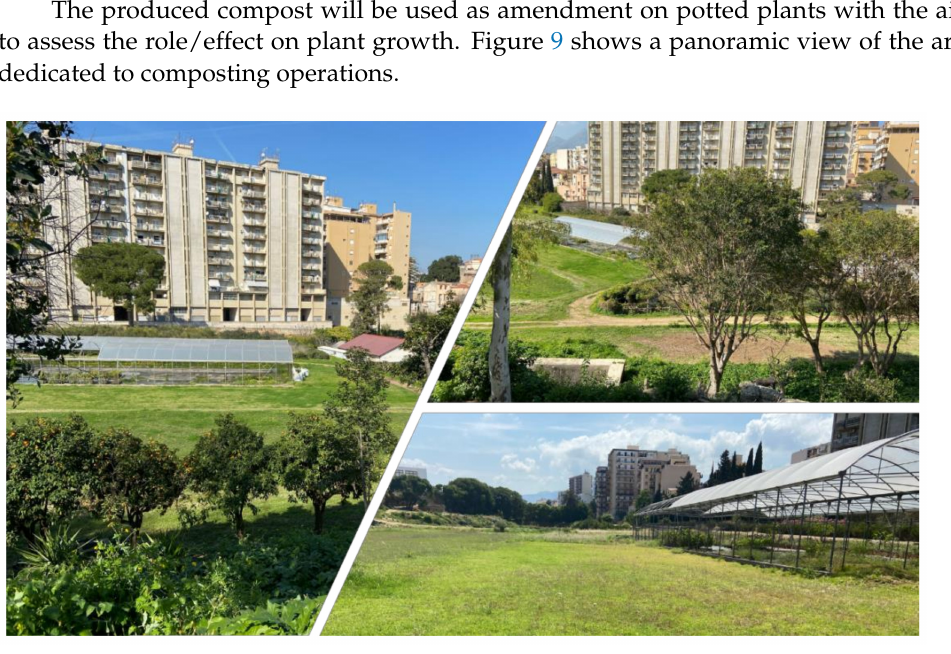
Figure 9. Panoramic view of the composting area.